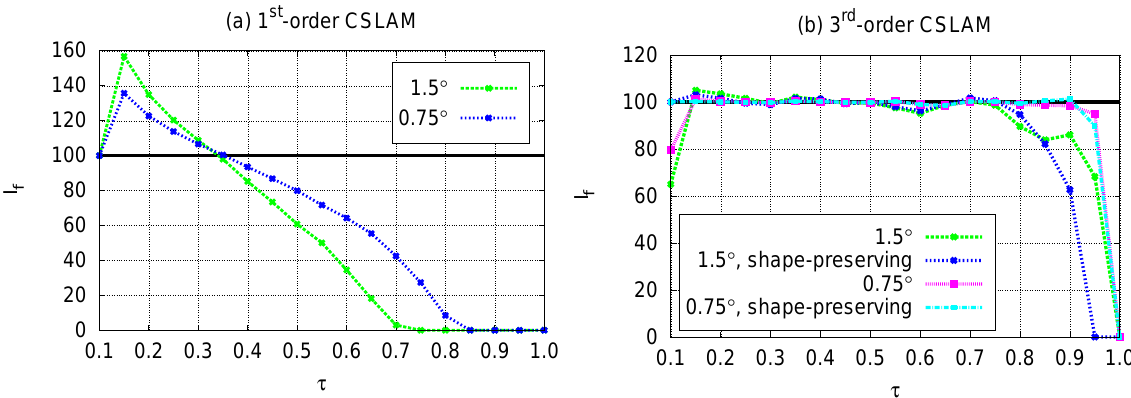
Fig. 6. Filament diagnostics ‘ f (t = T/ 2 ) as a function of threshold value τ for different configurations of the CSLAM scheme with Courant number 5.5. (a) first-order version of CSLAM at 1λ = 1 . 5 ◦ and 1λ = 0 . 75 ◦ , and (b) third-order version of CSLAM with and without shape-preserving filter at resolutions 1λ = 1 . 5 ◦ and 1λ = 0 . 75 ◦